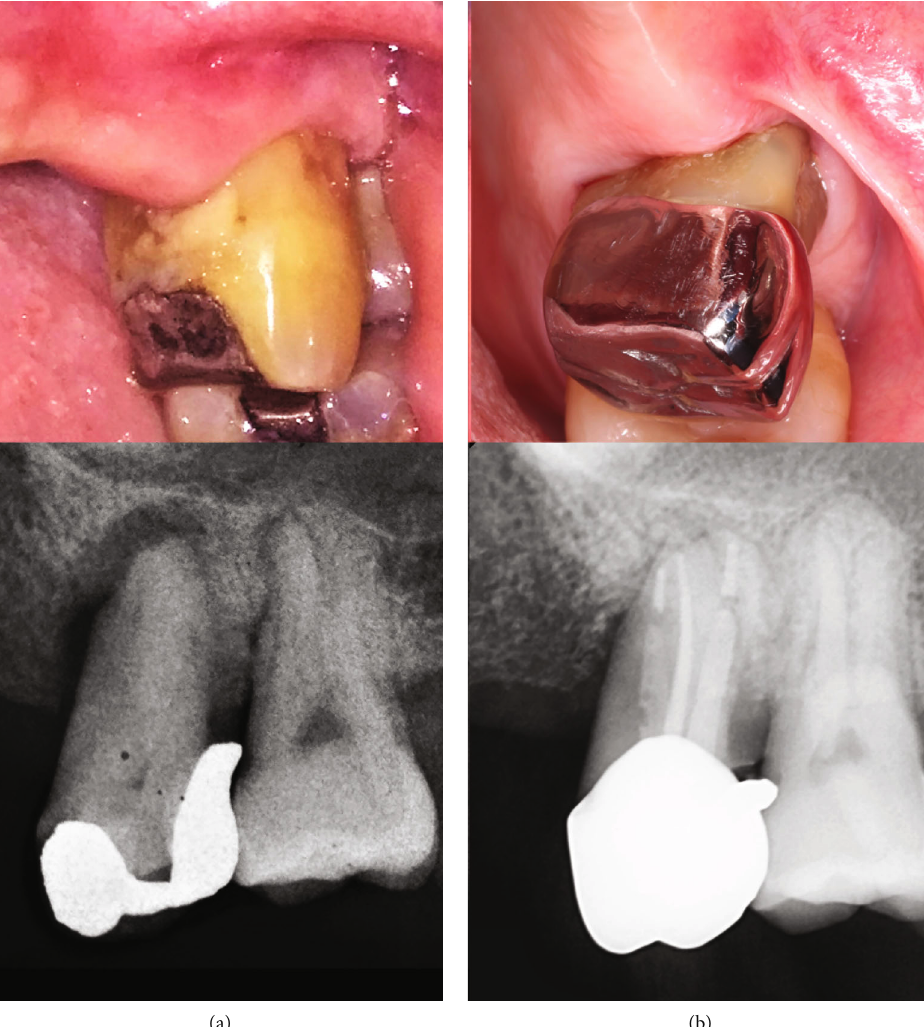
Figure 6: Comparison between (a) initial and (b) fi nal clinical and radiographic